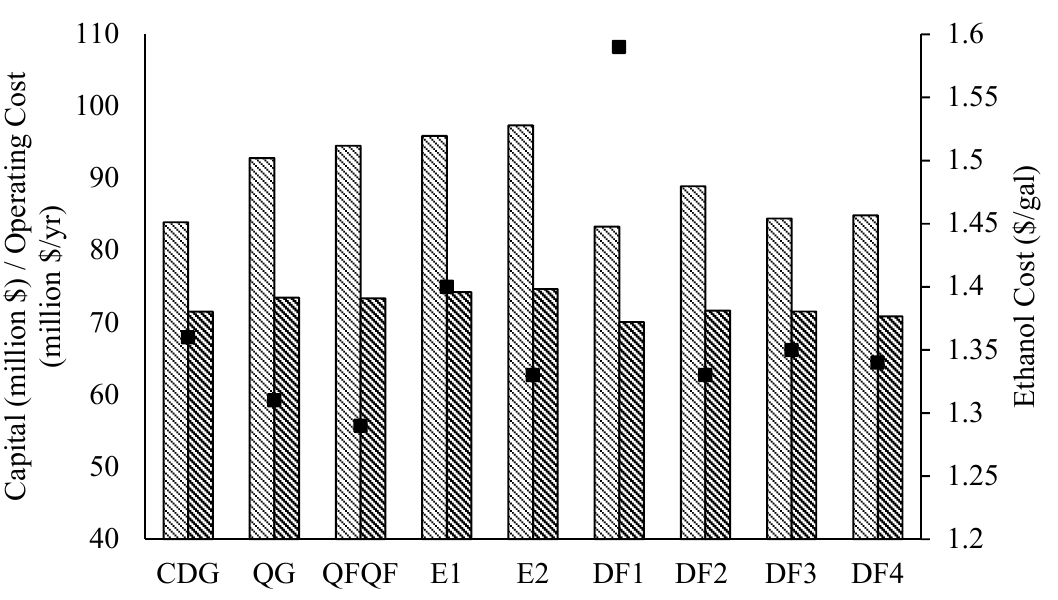
Figure 3. Summary of capital costs, operating costs and ethanol production costs in conventional and modified processes.